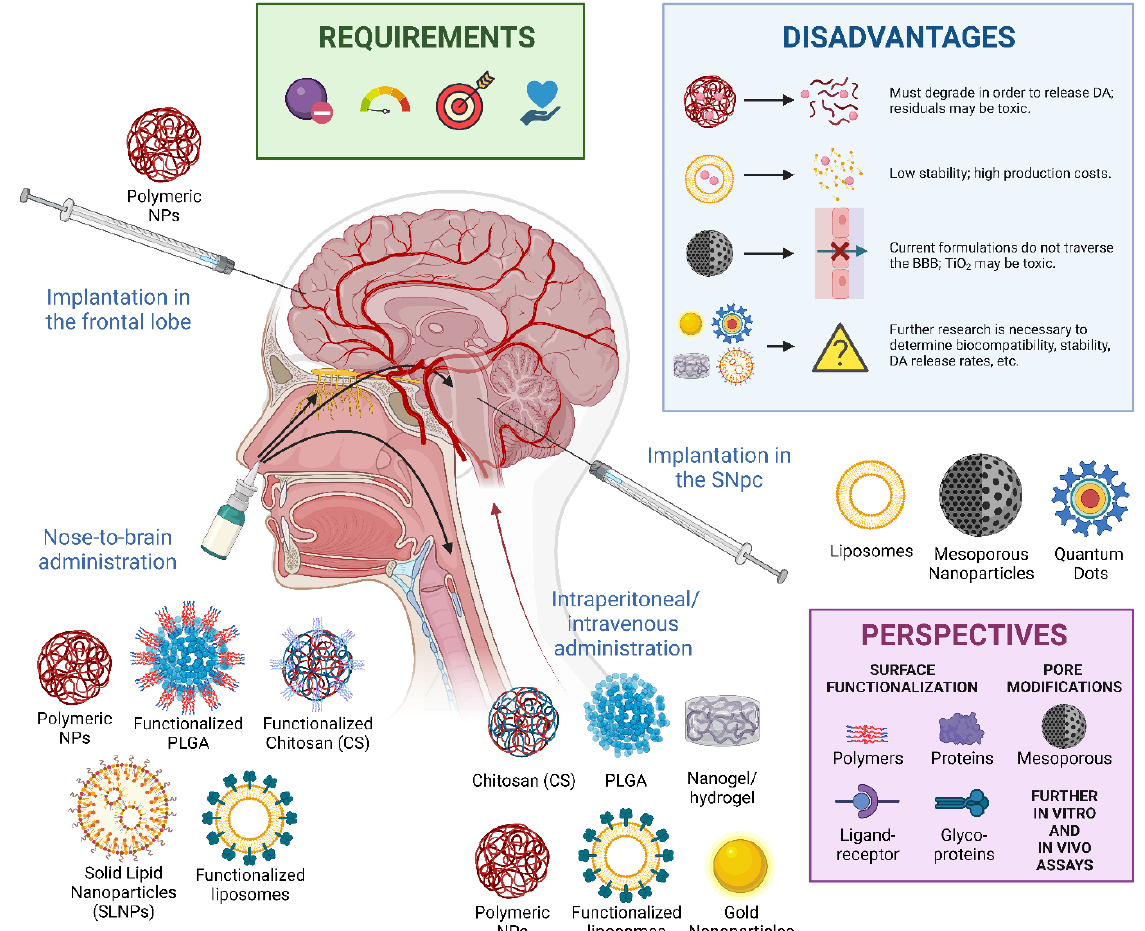
Figure 4. Current research on nanocarriers for controlled release of dopamine. The new nanocom-